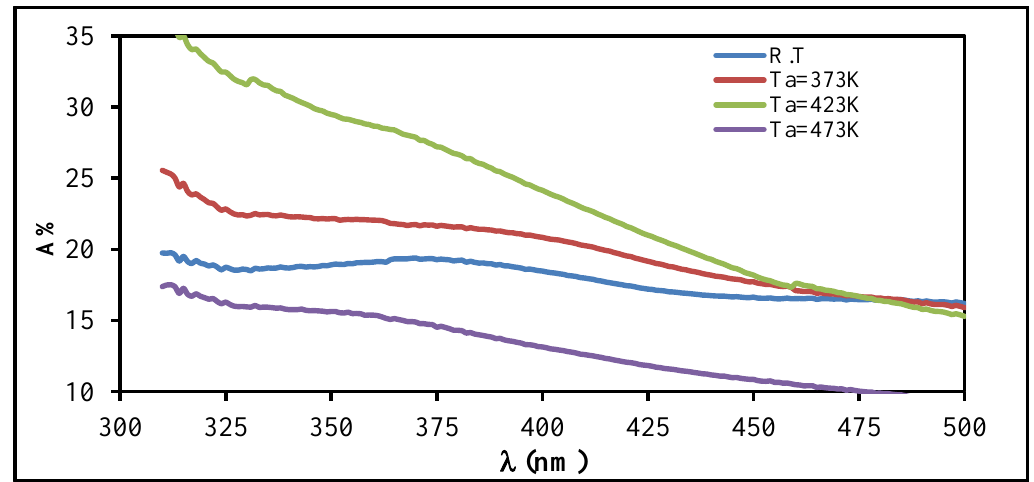
Fig. 3: Absorption spectra of as-deposited and annealed Alq different Ta.